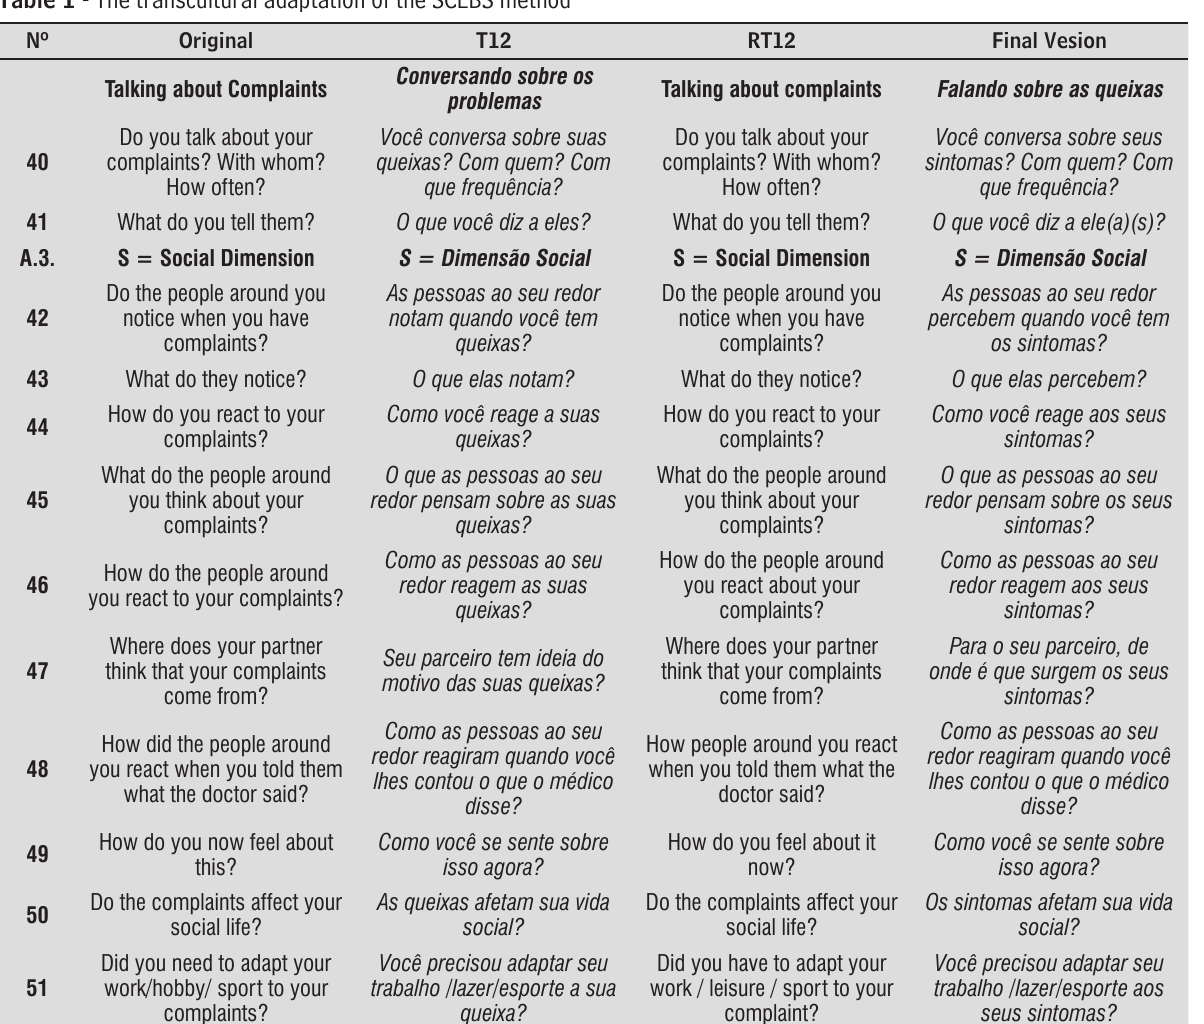
Table 1 - The transcultural adaptation of the SCEBS method